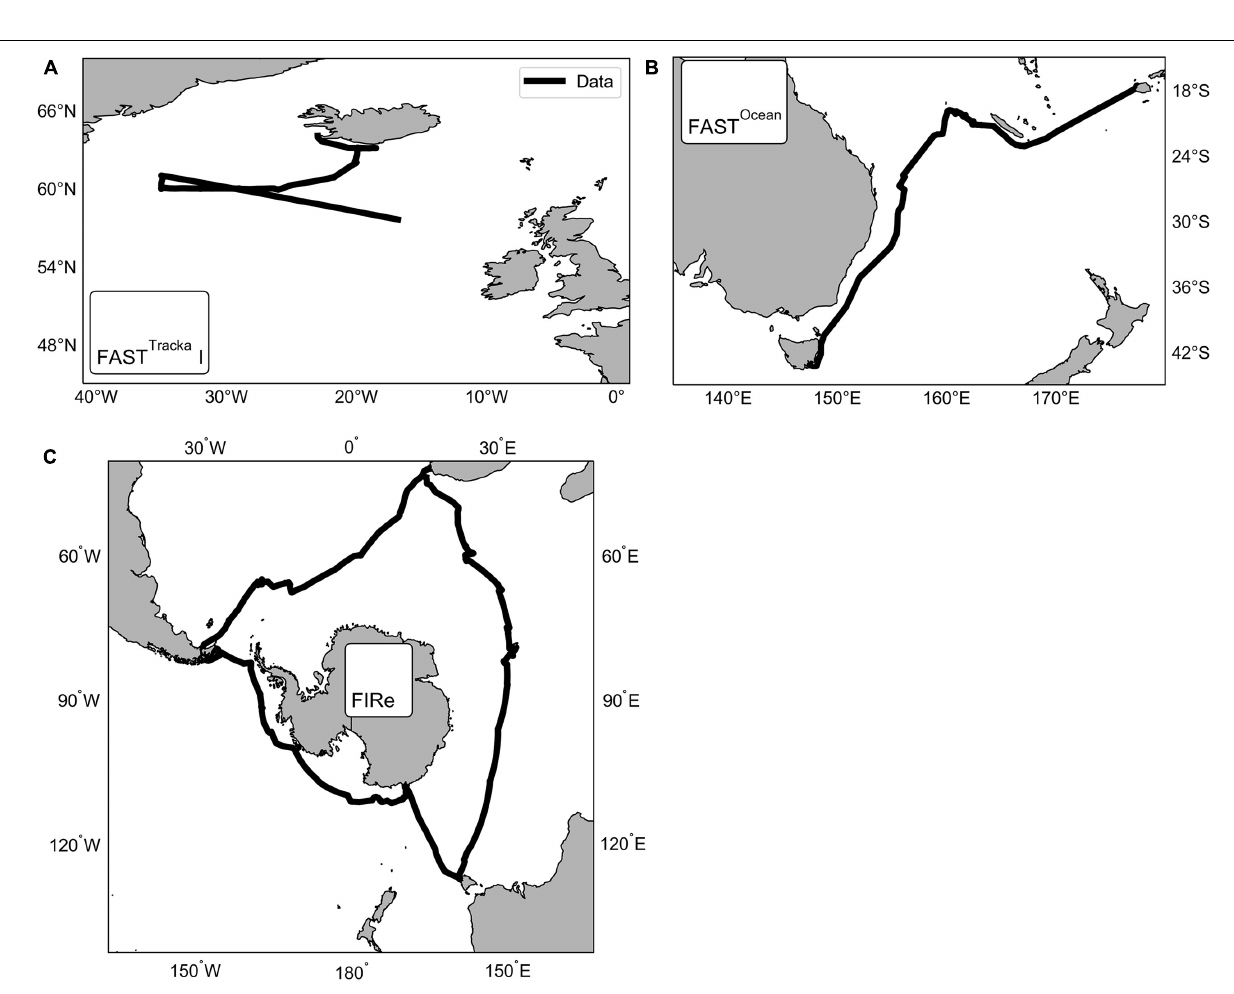
FIGURE 1 | Maps showing the locations of the data collected using three different active chlorophyll fluorescence instruments, CTG (A) FAST Tracka I (D350; North Atlantic) and (B) FAST Ocean (IN2016_T01; South Pacific), and (C) Sea-Bird Scientific (previously Satlantic) FIRe (ACE; Southern